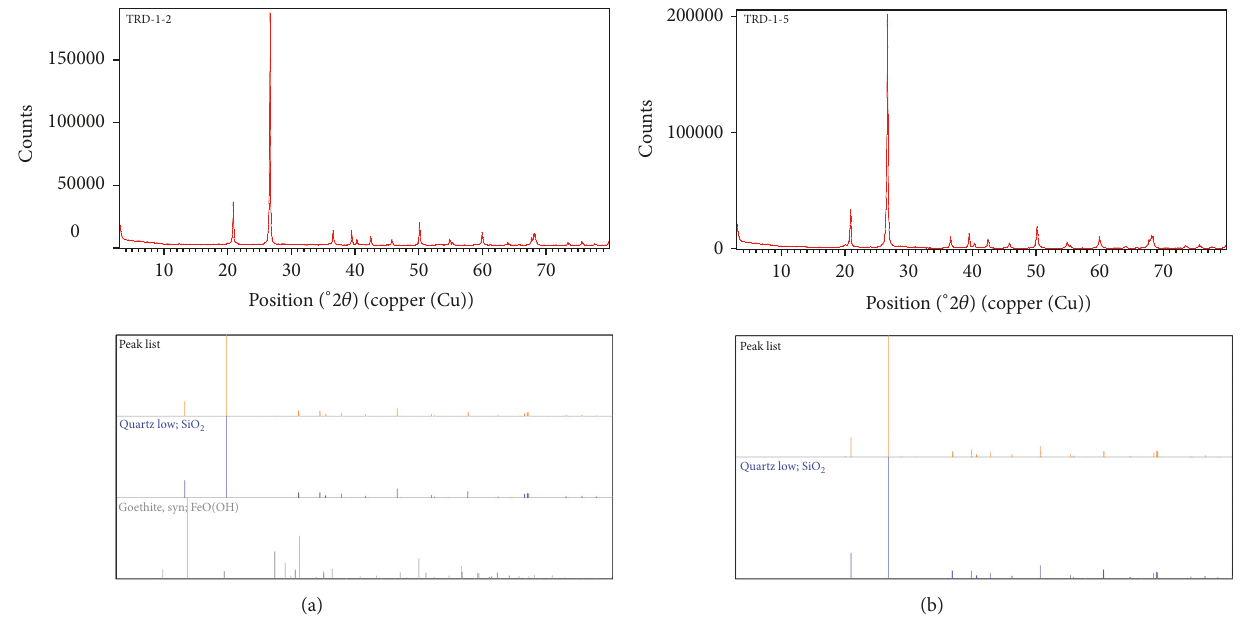
Figure 1: XRPD patterns of chert samples, named Trd 1-2 (a) and Trd 1-5 (b), representative of the two mineralogical compositions